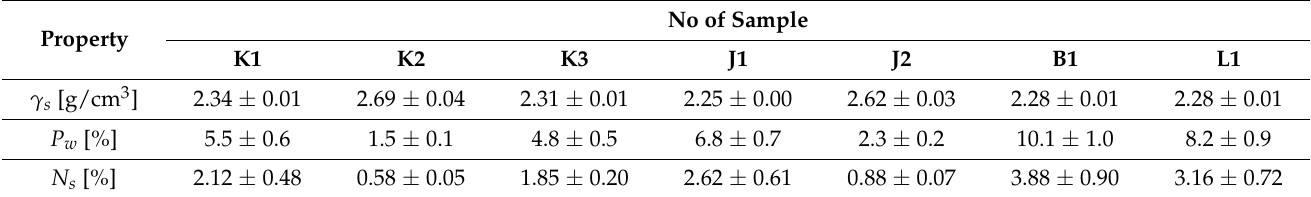
Figure 17. Classification of tested sandstones according to the Dott–Pettijohn triangle [24,25]. Table 3. Bulk density, effective porosity, and water absorption coefficient of the tested sandstones. No of Property